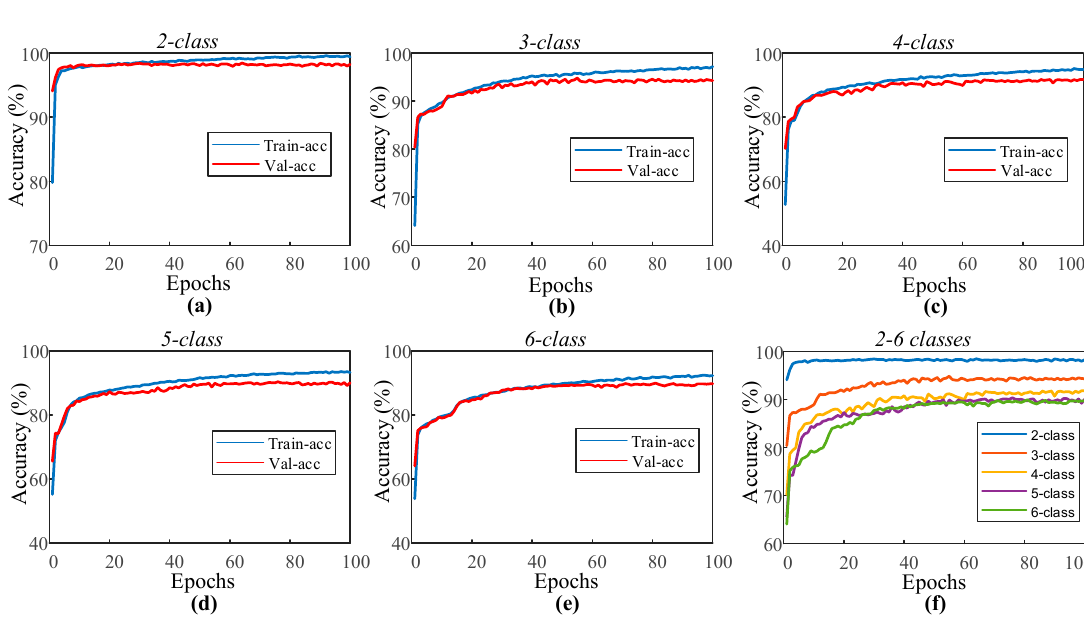
Figure 8. Performance graphs of the proposed 1D-CNN model with a single-channel EOG+EEG signal for the sleep-edf dataset: ( a ) two-class model, ( b ) three-class model, ( c ) four-class model, ( d ) five-class model, ( e ) six-class model, and ( f ) validation accuracy for the models with two to six classes.